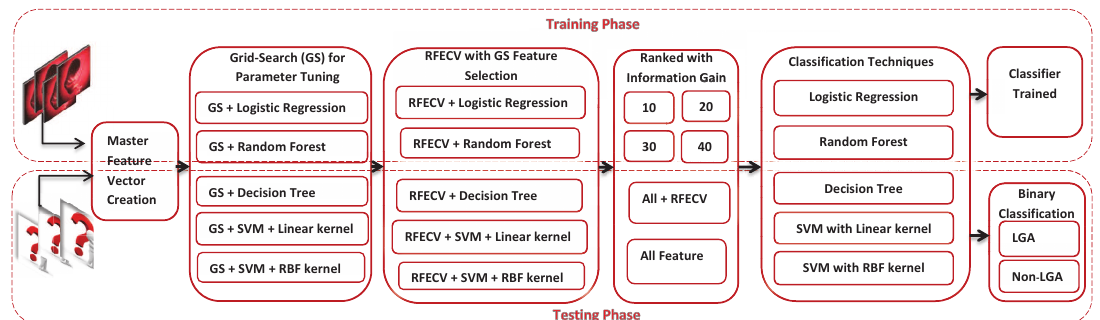
Scheme 1. The completemethodology of the proposed GridSearch + Recursive Feature Elimination with Cross-validation + Information Gain-based feature selection scheme for the establishment of an efficient Large for Gestational Age infants prognosis